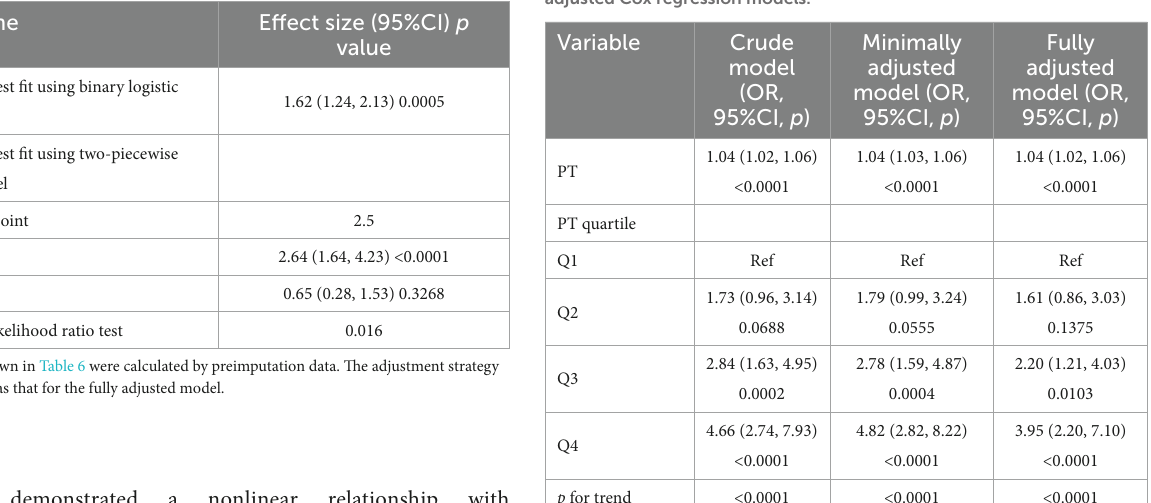
TABLE 4 Nonlinearity of the PT-INR (ratio) on ICU